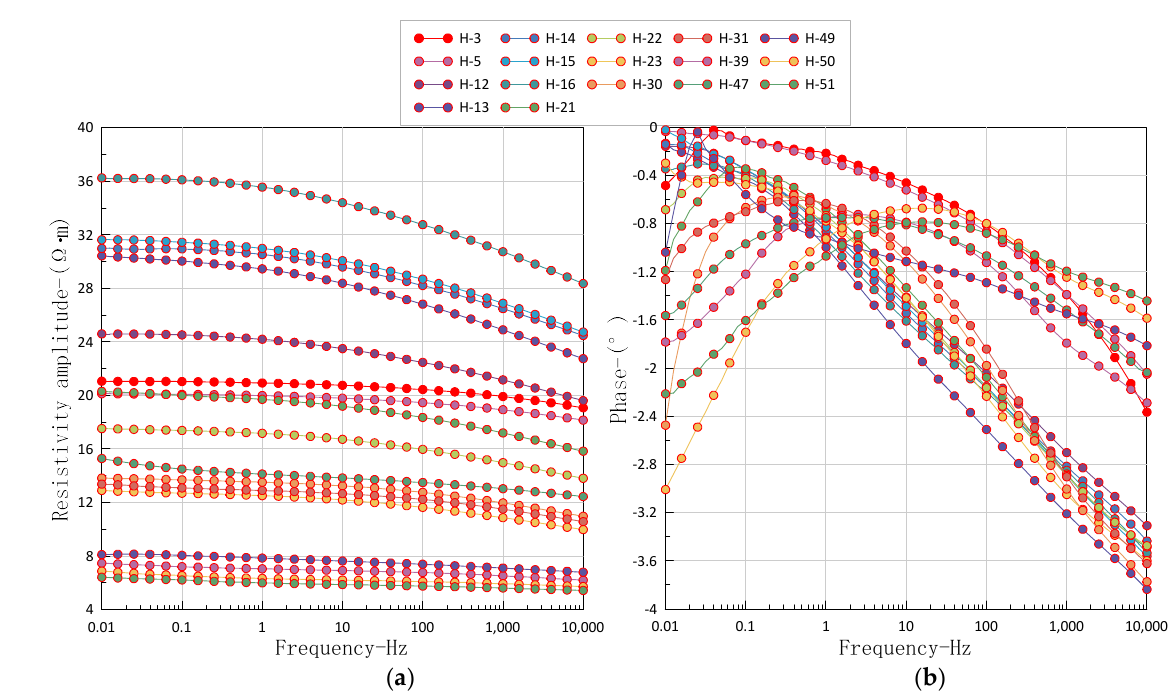
Figure 5. Amplitude and phase diagram of shale resistivity in H direction at normal temperature and pressure. ( a ) resistivity amplitude; ( b ) phase.